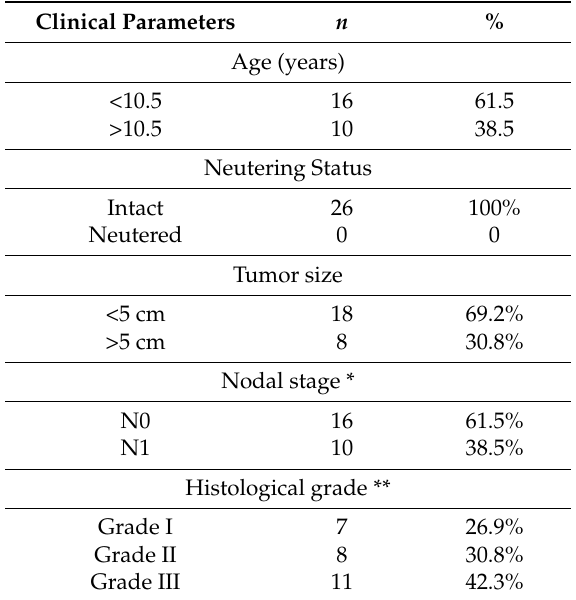
Table 1. Clinical parameters of female dogs affected by mammary gland tumors.